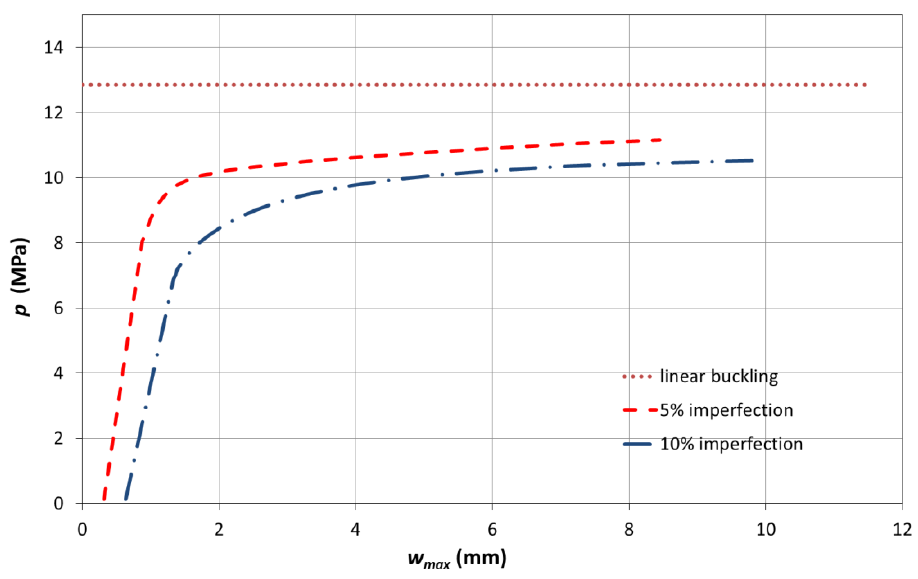
( b ) Figure 18. Maximum shell imperfections at the mid-section: ( a ) 5% and ( b ) 10% of the shell thickness. The results obtained for the critical buckling pressures after running the geometrically nonlinear buckling analyses are shown in Figure 19, which presents the critical buckling pressure obtained by the linear bifurcation analysis carried out in Section 4 for the shell with sliding stiffeners, and the two nonlinear curves, obtained for the same structure, considering the two imperfection values. These curves show how the maximum radial deflection in the shell varies as the hydrostatic pressure